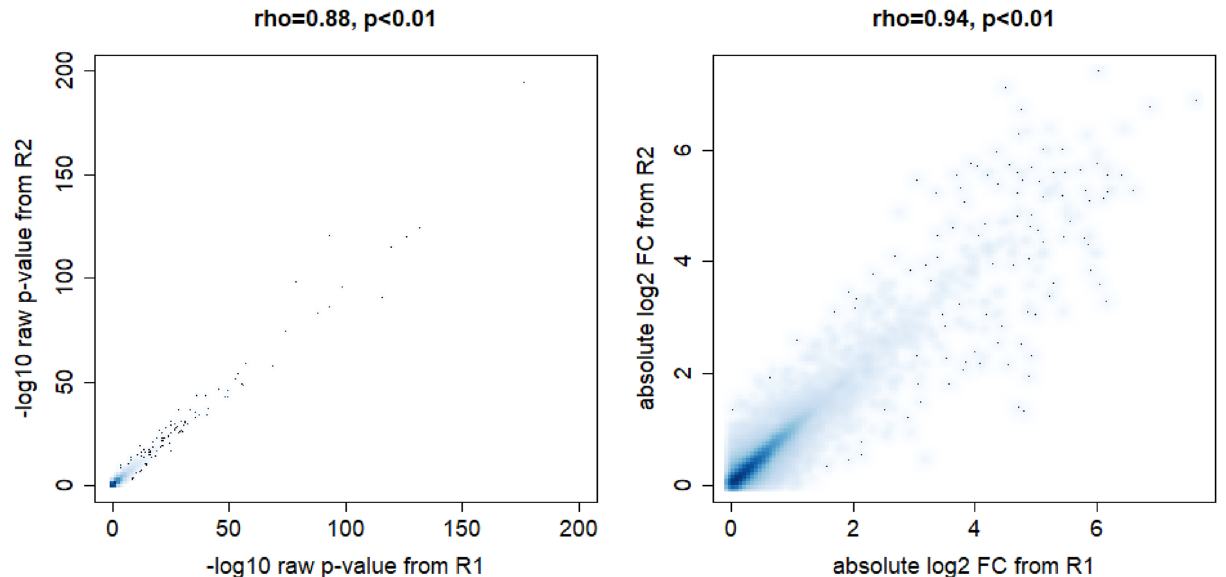
Figure 2. Smooth scatterplots of raw, gene-wise it p values generated from true experimental replicates R1 and R2 (left), and of absolute log2 fold changes (right). Spearman correlations between R1 and R2 are high, showing in principle a similar ranking of genes between technical replicates in an RNA-seq experiment. However, the plots also show a high number of genes which diviate stronger from the bisecting line, i.e. genes which would be selected by one experimental replicate but not by the